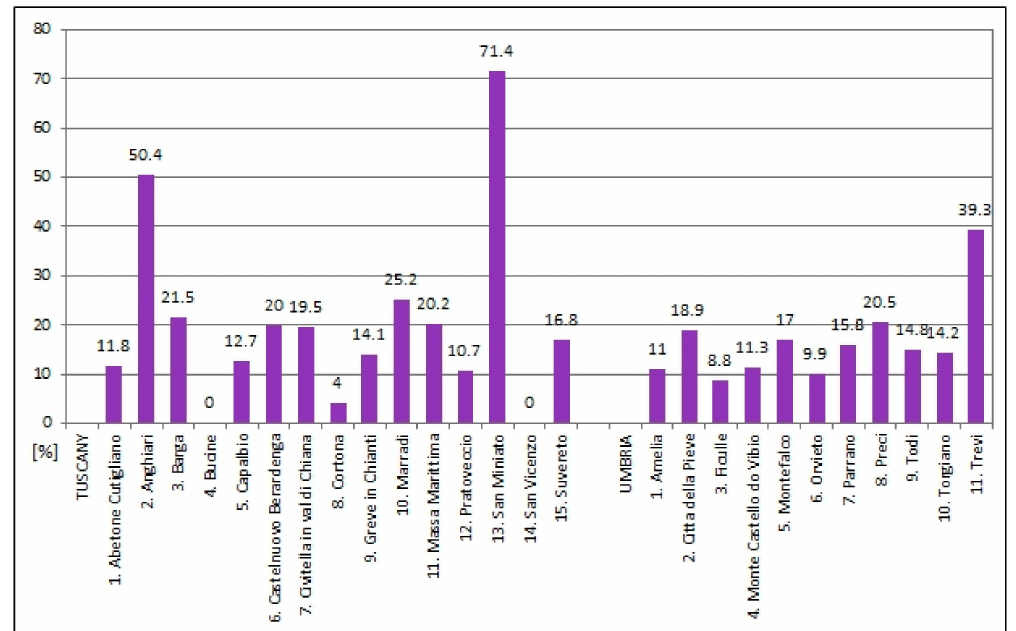
Figure 9. Increase in the developed area of Italian towns. Source: own elaboration. Key: zero values denote towns where the historical urban fabric was not preserved.